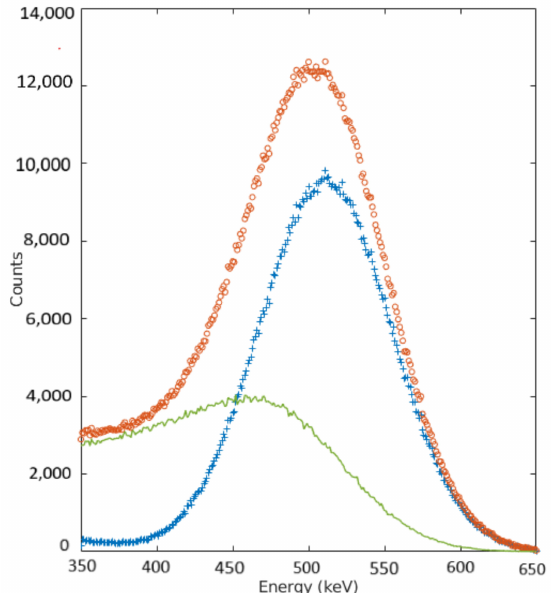
Figure 1. Energy distribution of the registered events from a 16 cm radius water-filled cylinder with a line source in the center. Total spectrum (empty dots), trues (crosses), and scatter (solid line). The scatter and true contributions to the total spectrum can be